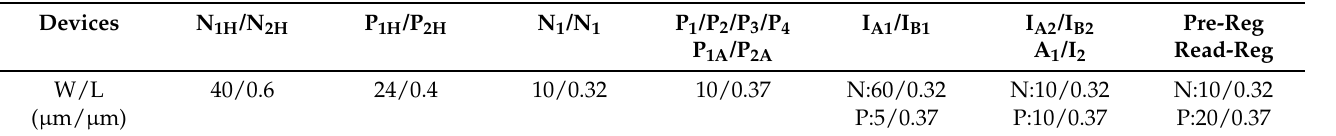
Figure 6. Improvements in propagation delay, symmetry, and startup circuit. Table 1. Devices parameters of the proposed